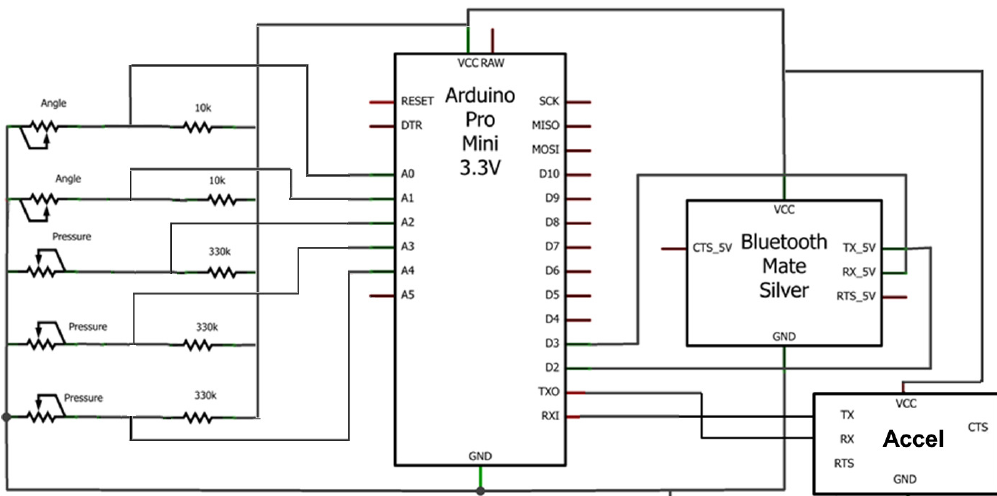
Figure 7. General